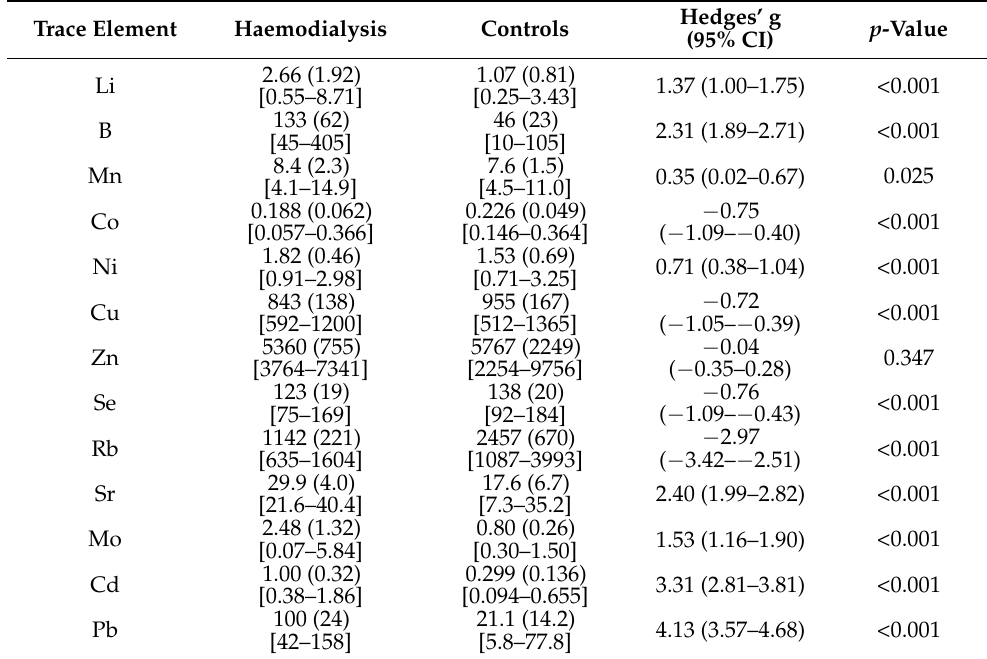
Table 1. Mean (SD) and [range] for the trace element concentrations ( µ g/L) in whole blood of haemodialysis patients and controls. Hedges’ g was used to estimate the effect size of haemodialysis on trace element